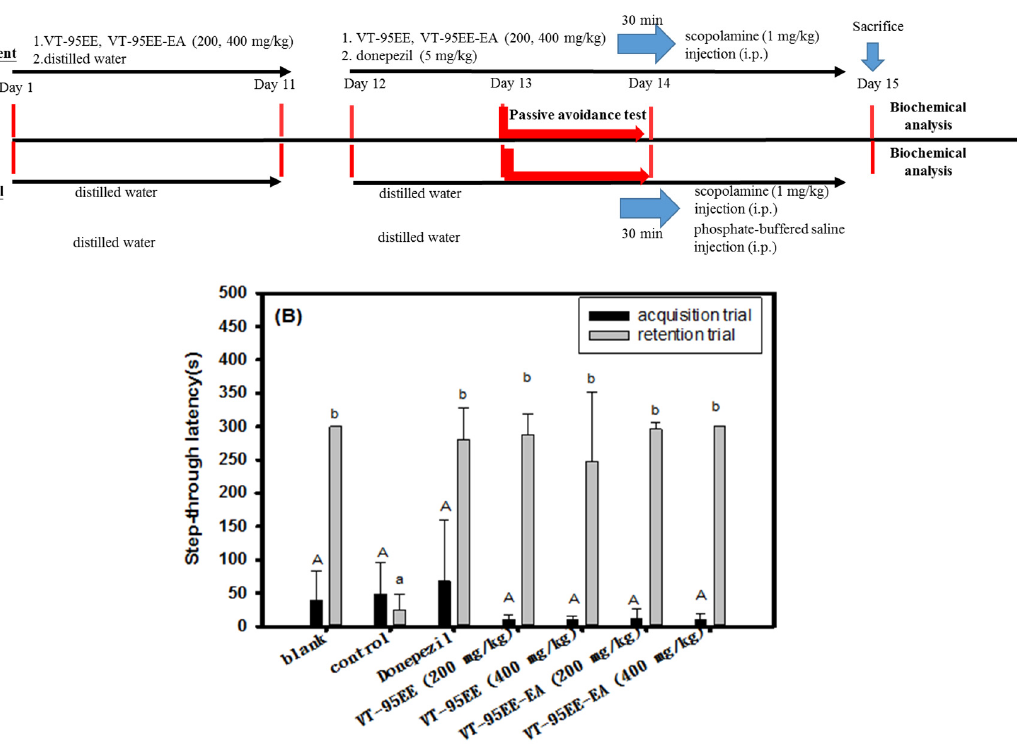
Figure 4. Effects of VT-95EE or VT-95EE-EA pretreatments (200 and 400 mg/kg) on the improvements of impaired learning and memory functions in scopolamine-treated amnesiac ICR mice. ( A ) The experimental protocol. There were seven groups (six heads of ICR mice/group), including the blank, the control, the VT-95EE (200, 400 mg/kg) groups, the VT-95EE-EA (200, 400 mg/kg) groups, and donepezil group (the positive control); ( B ) the learning and memory behaviors (the step-through latency, s) in the passive avoidance test. The scopolamine-injected mice without any sample treatments were used as the control. The one-way analysis of variance (ANOVA) and the post hoc Tukey’s test were used to compare the differences among multiple groups in the step-through latency ( B ). It was considered as the significant difference ( p < 0.05) among groups which marked the different uppercase letters in the acquisition trial or marked the different lowercase letters in the retention trial.